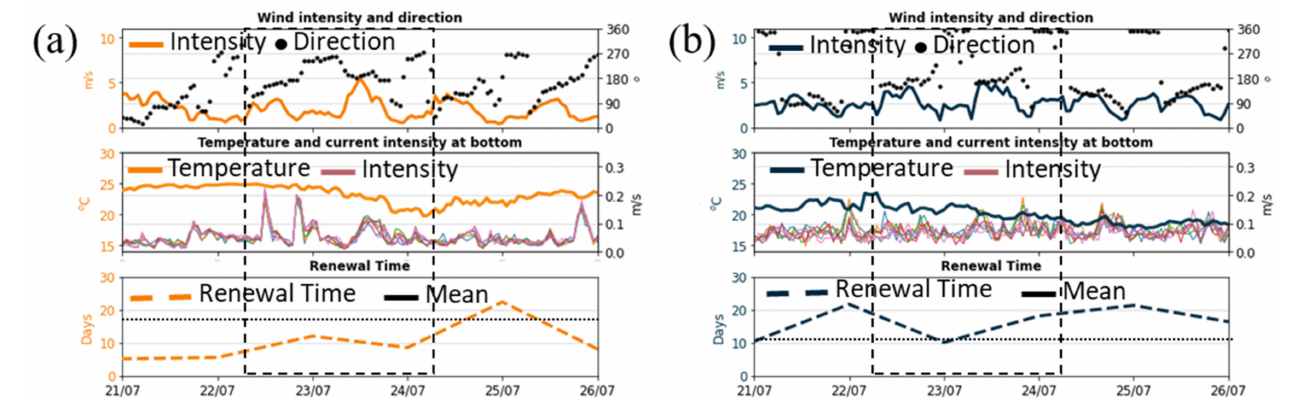
Figure 9. Detailed evolution of the second episode of abrupt temperature increases in Barcelona ( a ) and Tarragona ( b ) harbours. Top row: wind intensity (solid line) and wind direction (black dots). Middle row: temperature (thick line) and current speed near the seabed (the thin coloured lines represent the intensity in the deeper layers). Bottom row: turnover times (the black line is the average turnover time of the harbour). The dashed black squares correspond to the day of upwelling.